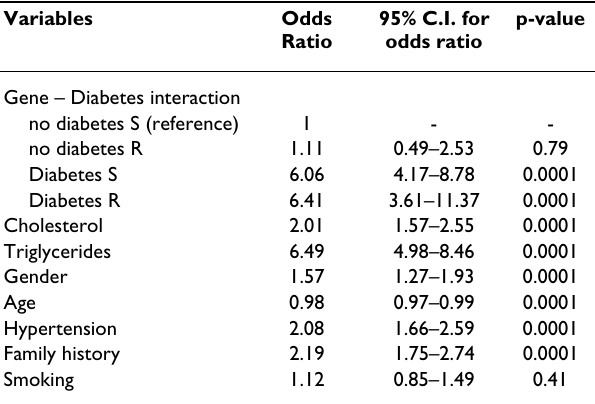
Table 3: Multiple logistic regression analysis for the interaction between E-selectin genotypes and other risk factors for coronary artery disease Variables Odds